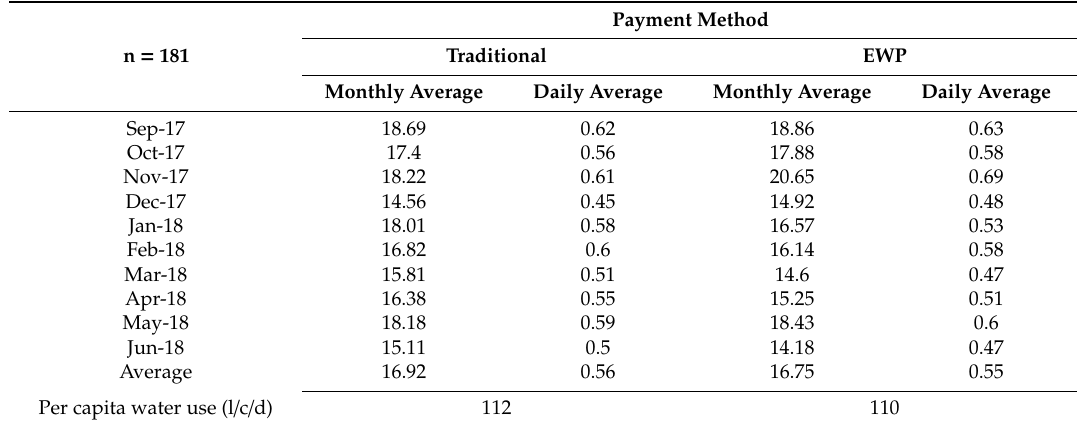
Table 4. Average monthly and daily water use per payment method of sampled households in m 3.